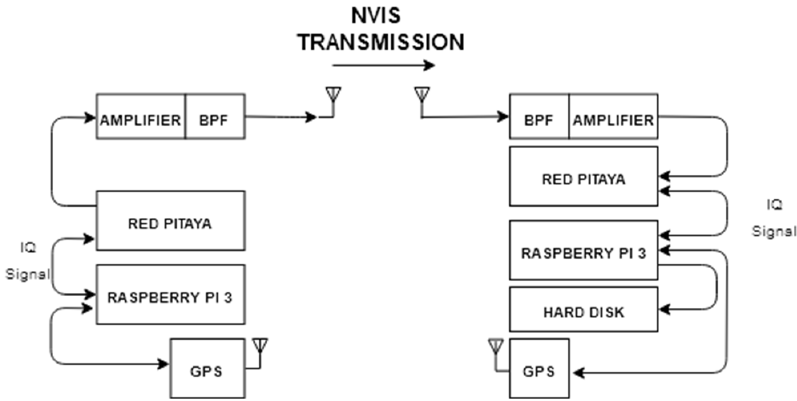
Figure 3. Block diagram of the sounding system.